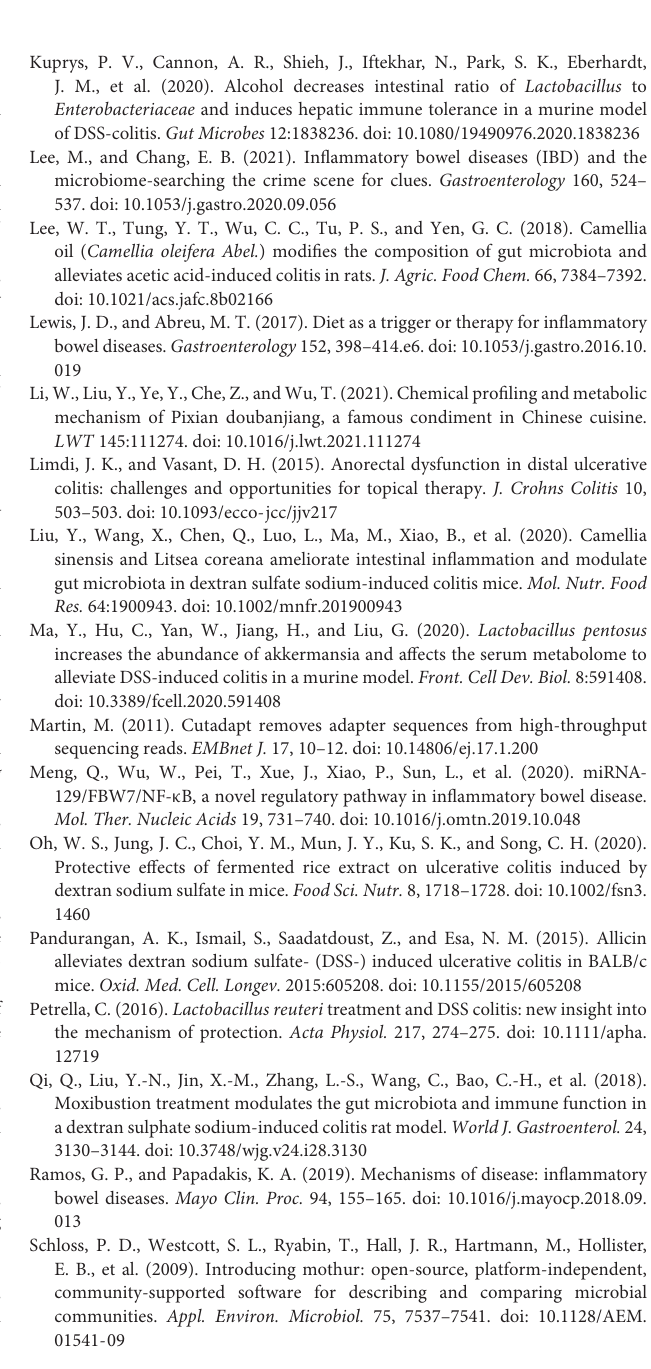
Supplementary Figure 1 | Comparison of theaflavins content between Tibetan tea (A) and Pu-erh tea (B) by UHPLC-Q-TOF. Supplementary Figure 2 | Effects of TTE on colon length of mice after colitis induction. The arrow represents the site of colonic edema. Scale bars = 1